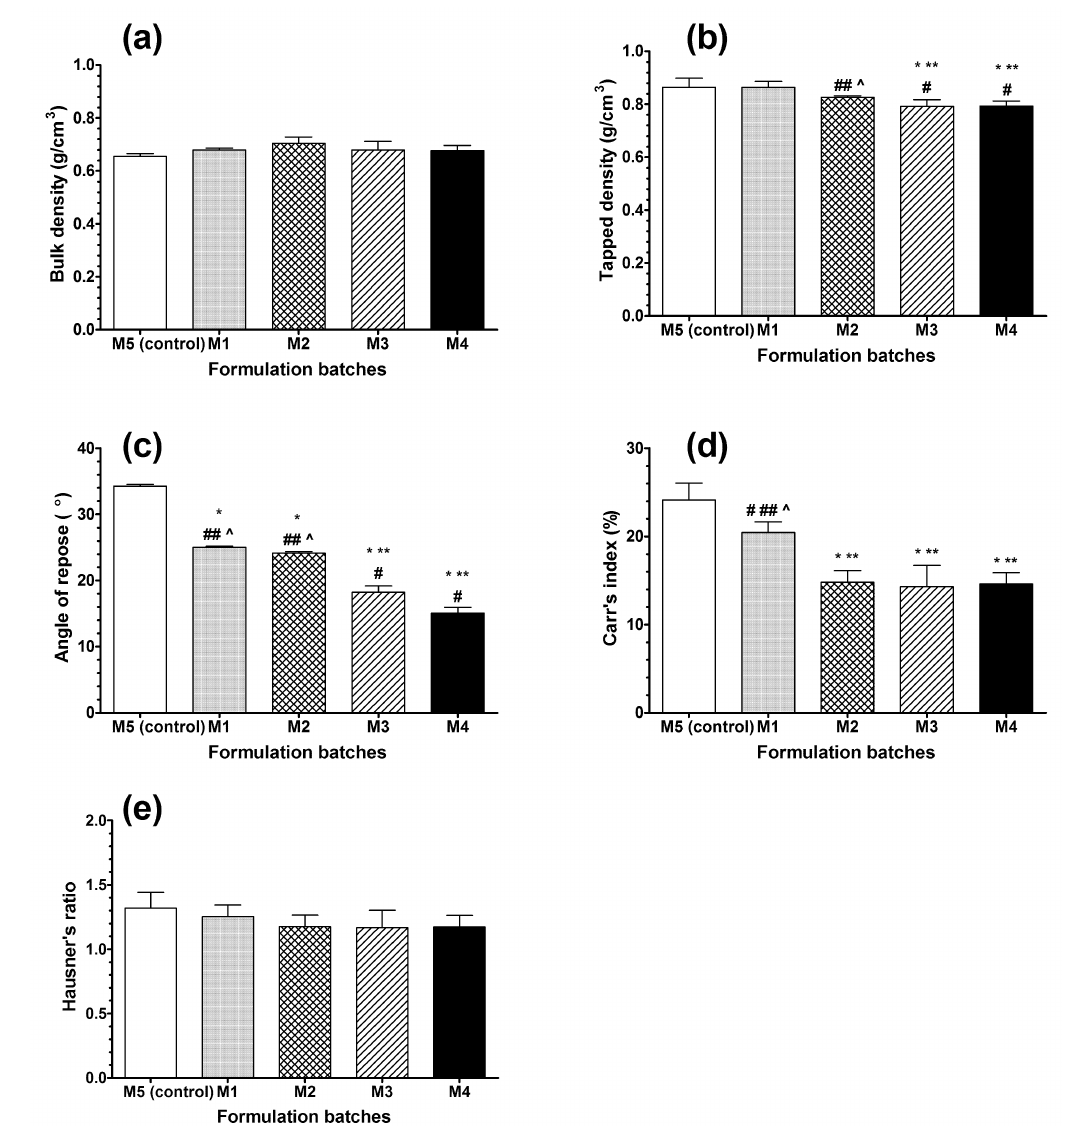
Figure 2. Pre-compression parameters: ( a ) Bulk density, ( b ) tapped density, ( c ) angle of repose, ( d ) Carr‘s index, and ( e ) Hausner‘s ratio of the prepared powder blends. Data are presented as the mean ± SD, n = 5. The results were analyzed with one-way analysis of variance (ANOVA) followed by Tukey’s multiple comparison test. The batches were compared to the control and to each other. p < 0.05 showed a statistically significant difference: * compared to control (M5), ** compared to M1, # compared to M2, ## compared to M3, ^ compared to M4.